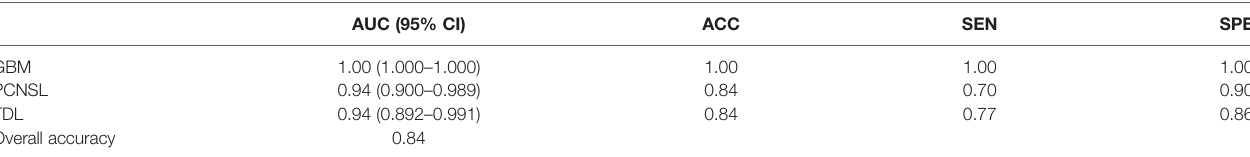
TABLE 3 | Diagnostic performance of the model using the lesion area.